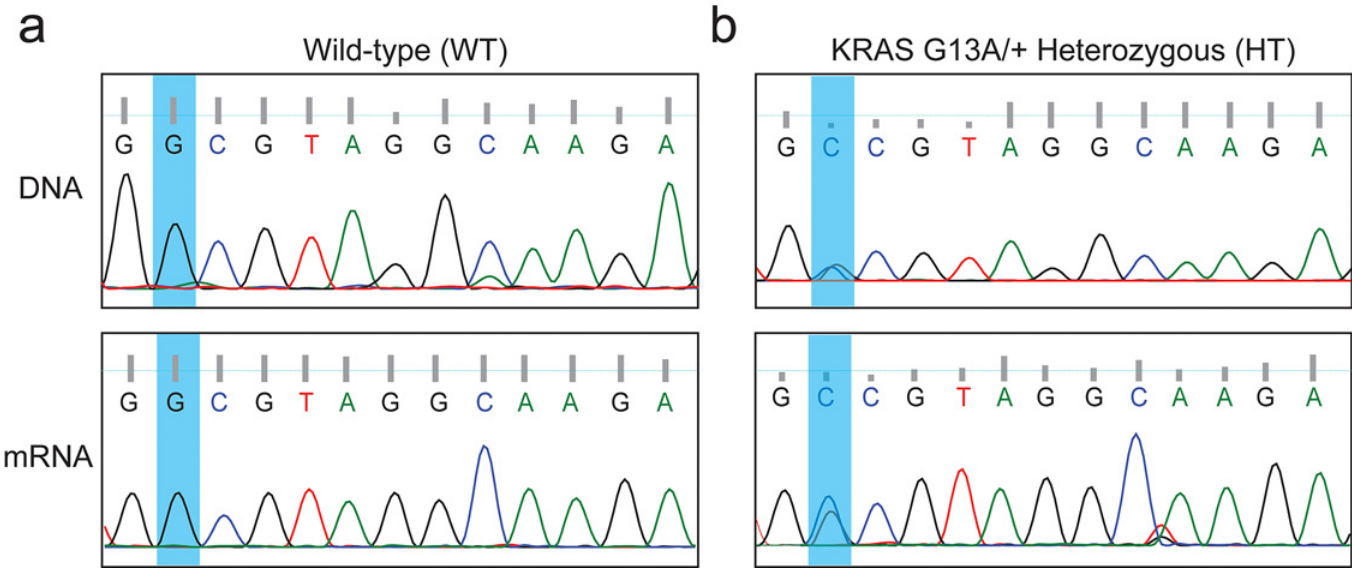
Fig 2. CRISPR/Cas9-mediated generation of a heterozygous KRAS G13A/+ stable SW48 cell line. Genomic DNA or mRNA were prepared from the KRAS wild type (WT) or G13A/+ SW48 (HT) cells and were used as PCR templates to isolate the cDNA fragments harboring the 13 th codon of the KRAS gene. (a) The Sanger sequencing results of the genomic DNA or mRNA samples from SW48 WT cells. (b) The Sanger sequencing results of the genomic DNA or mRNA samples from SW48 HT cells.